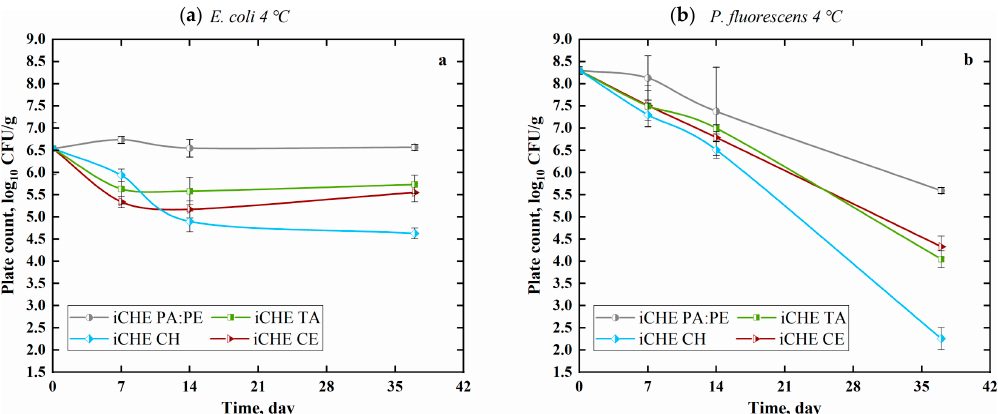
Figure 1. The effect of biopolymer films (CH, TA:CH, CE:CH) on bacterial count on cheese during storage at 4 °C inoculated with: ( a ) E. coli and ( b ) P. fluorescens . Values are means ( n = 2 × 3) with standard errors that are significantly different within columns ( p < 0.05; Table S1). tannic acid (TA), chitosan (CH), chestnut extract (CE), polyamide (PA), polyethylene (PE), inoculated cheese (iCHE).